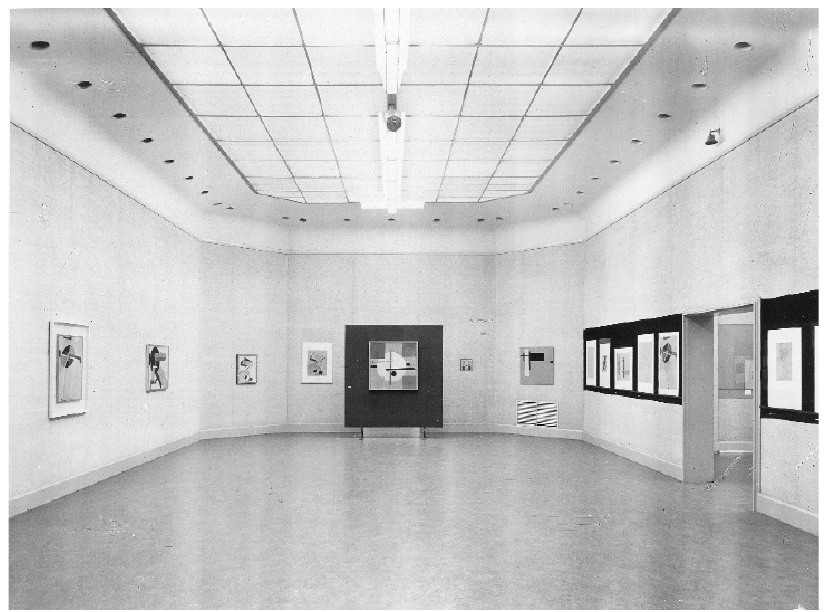
Figure 6. View of one of the rooms in the exhibition ‘El Lissitzky’, Van Abbemuseum, 1965. Photo: F. v.d. Bichelaer. F. v.d.